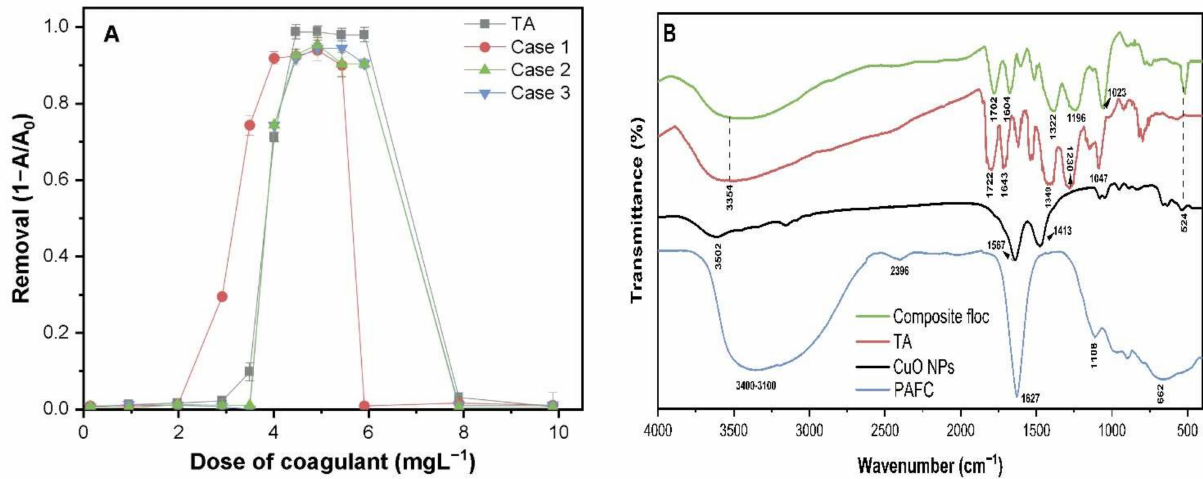
Figure 6. ( A ) Removal efficiencies of 3 sets of TA-CuO NP suspensions and the dissolved TA by PAFC; ( B ) FTIR spectra of pristine chemicals, i.e., CuO-NPs, PAFC, TA and composite floc obtained at optimum